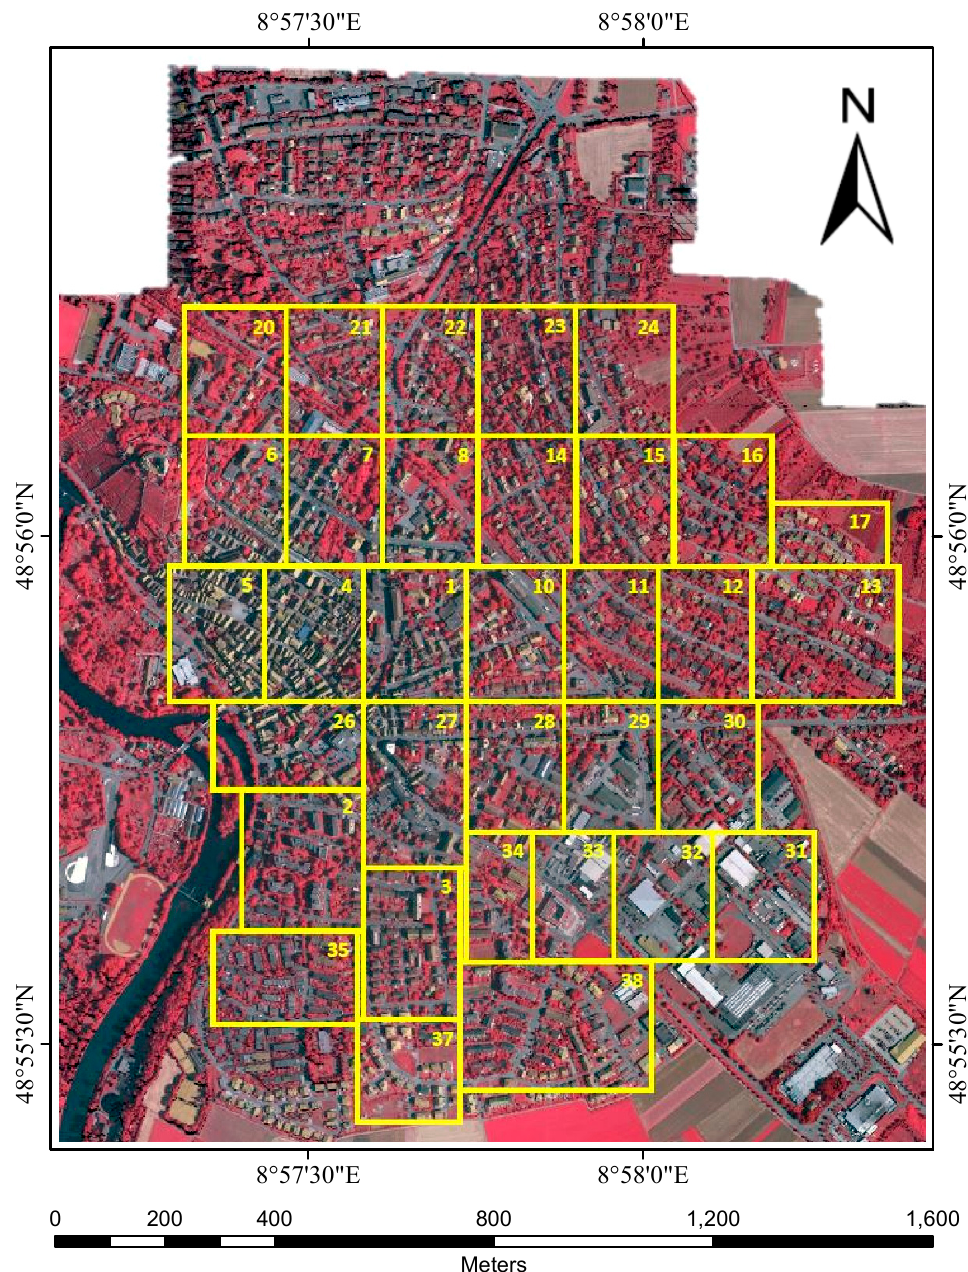
Figure 9. The true orthophoto of the test area, which is divided into 33 tiles.